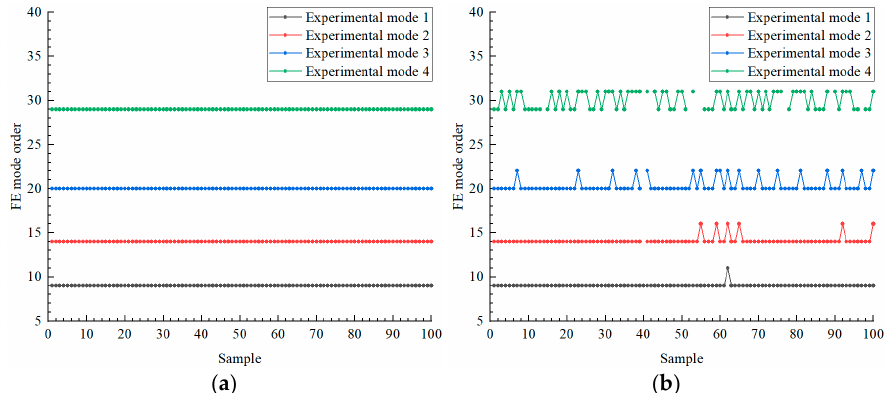
Figure 12. Switching range of the concerned mode orders. ( a ) First model-updating approach and ( b ) second model-updating approach.